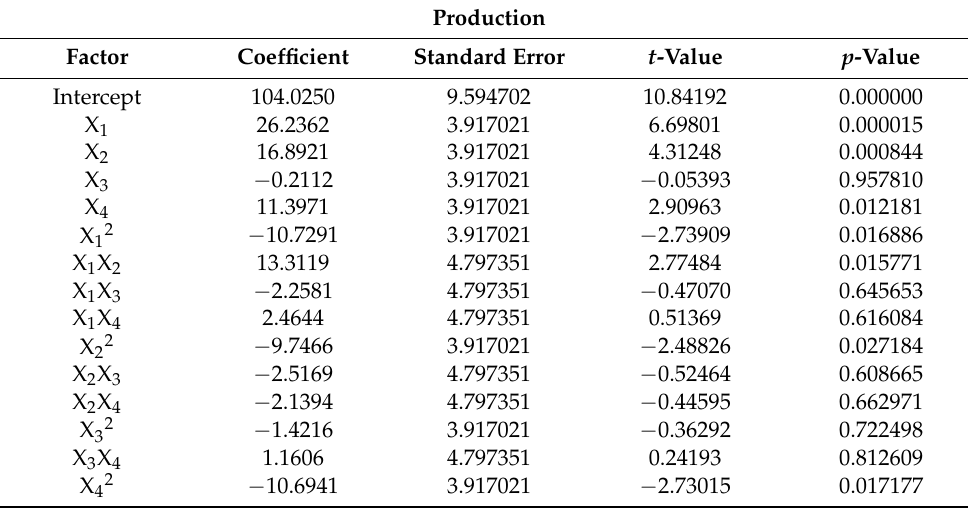
Table 5. Coefficients of model estimated by linear regression for lactic acid production and resid- ual